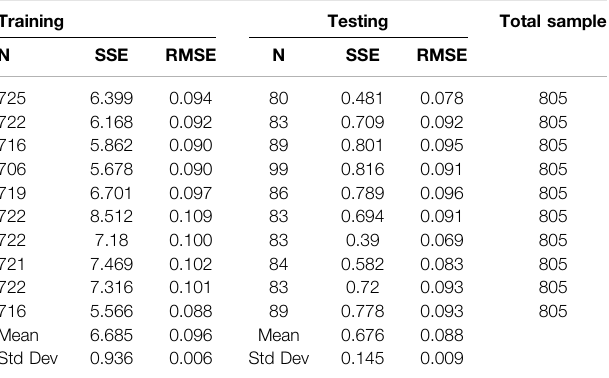
TABLE 8 | ANN RMSE values for training and testing. Training